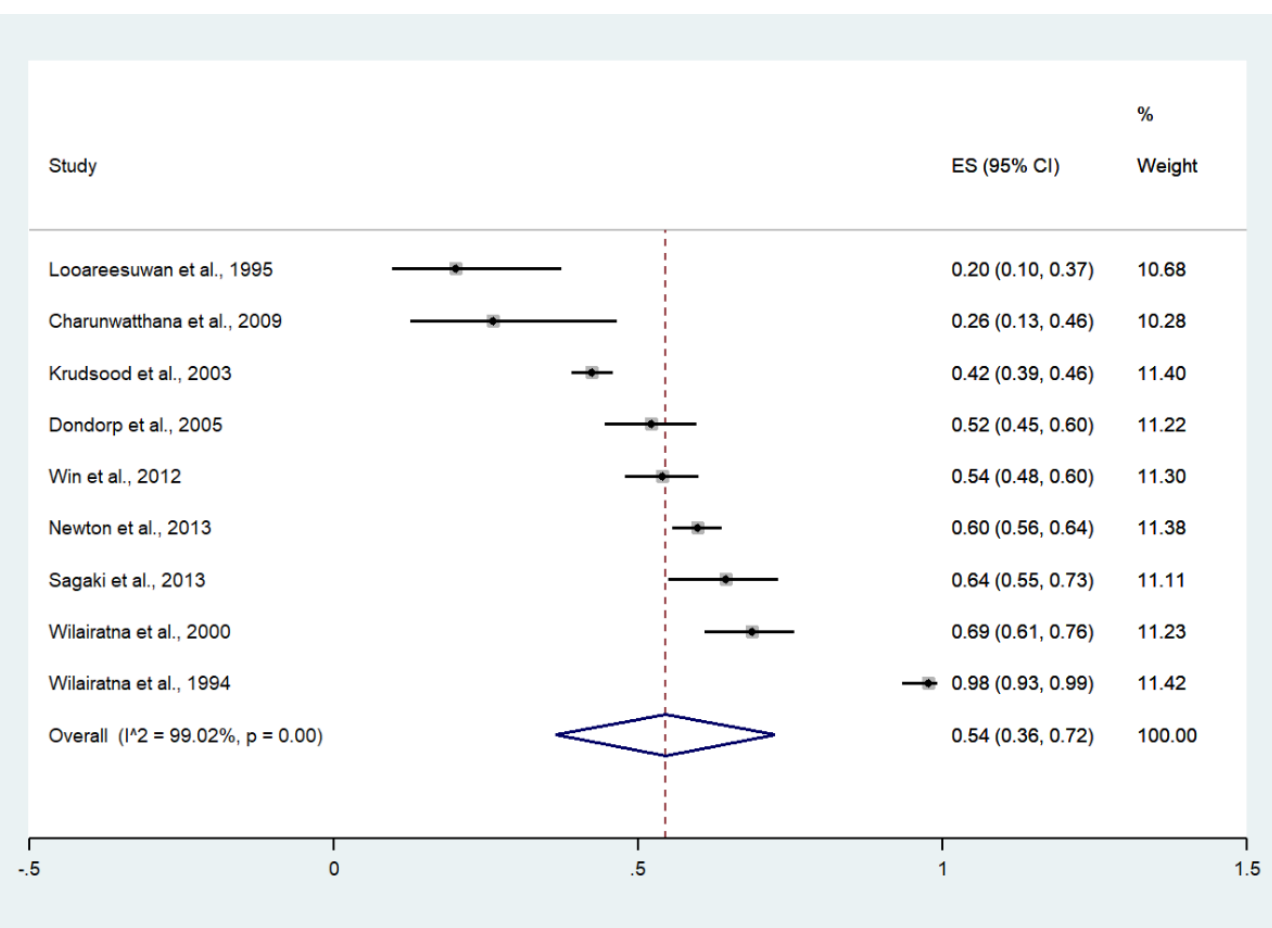
Figure 3. The pooled prevalence of jaundice among patients with severe malaria in Thailand. The label for the x-axis is the scale of estimated prevalence. Abbreviations; ES, estimated prevalence; CI, confidence interval .